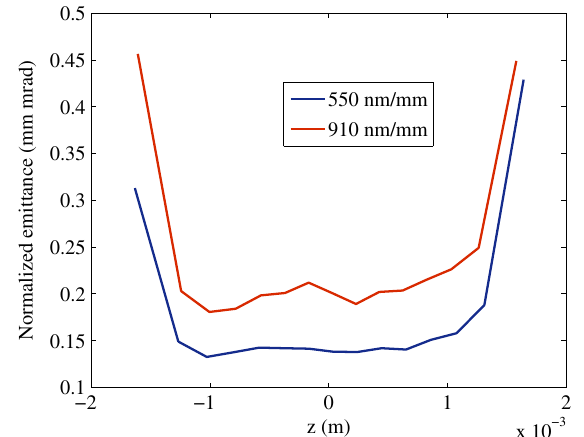
FIG. 5. Emittance along the bunch for the optimized layout of the CTF2 gun SwissFEL injector. The optimizations are performed assuming a normalized intrinsic emittance of 910 nm = mm and 550 nm = mm. The results are also compared with the design, as reported in [23] and removing the different contribution of the normalized intrinsic emittances.